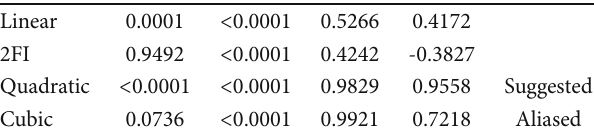
Table 4: Fit summary of the analysis.